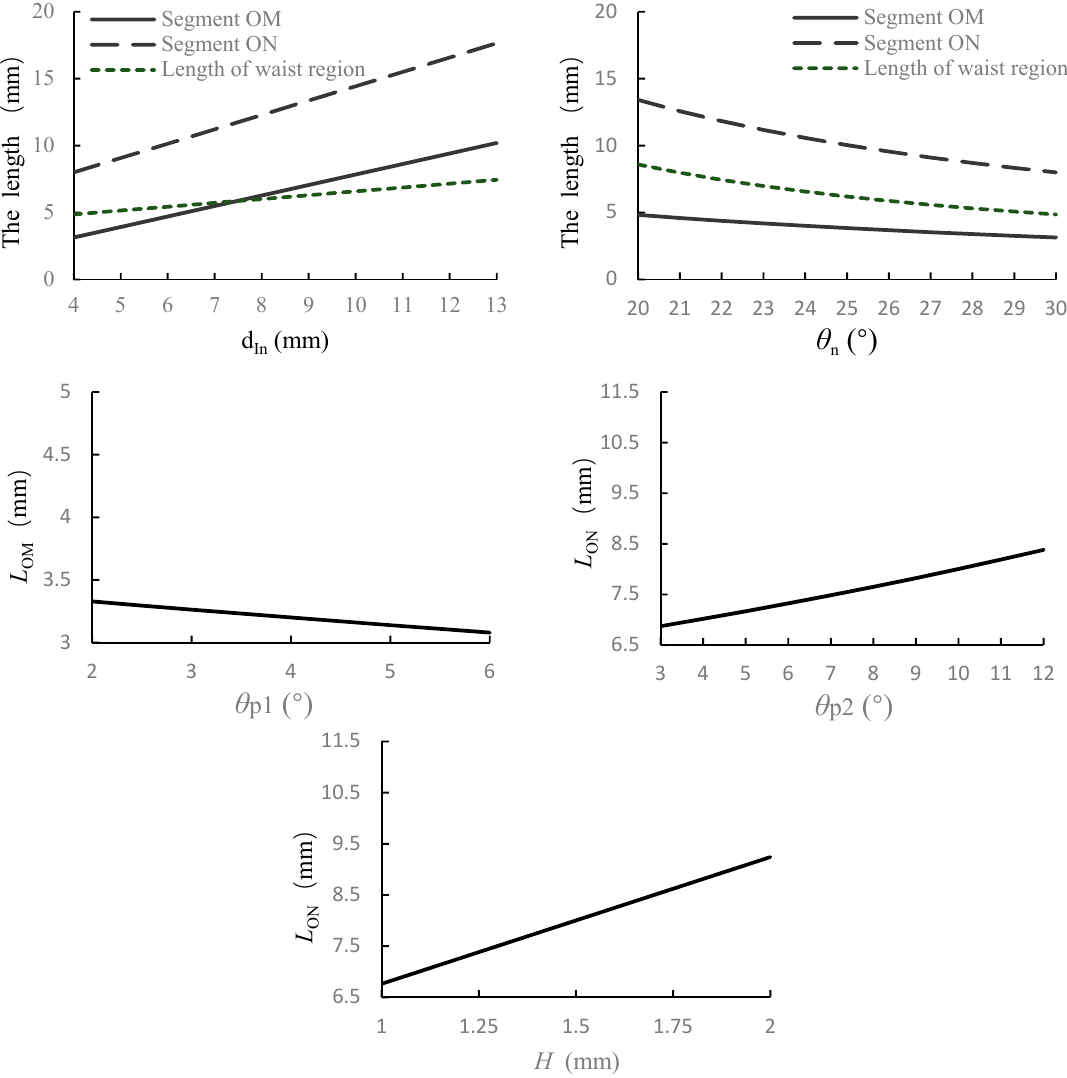
Figure 9. The effects of each parameter on L OM and L ON. Table 3. Sensitivity of L OM and L ON to each parameter.